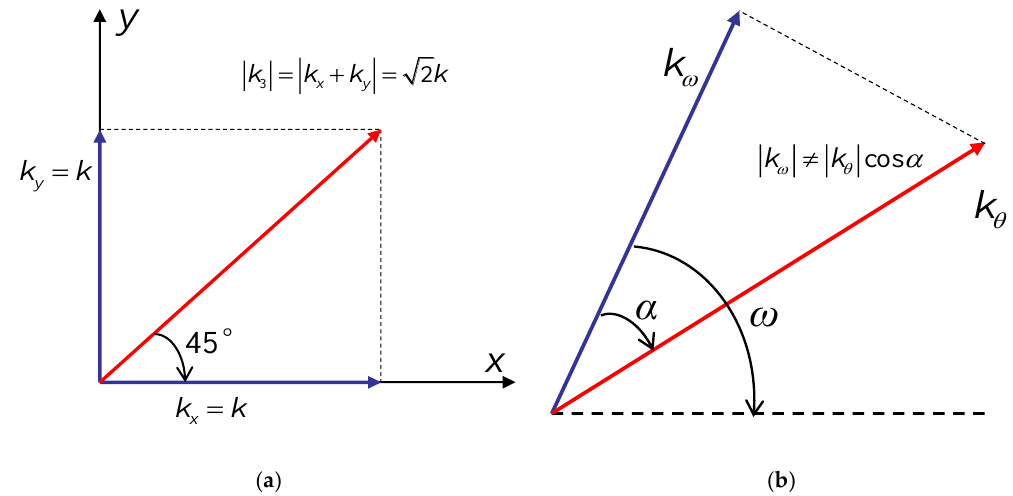
Figure A1. Schematic for incorrect composition and decomposition of permeability vector. ( a ) composition of permeability vector; ( b ) decomposition of permeability vector.